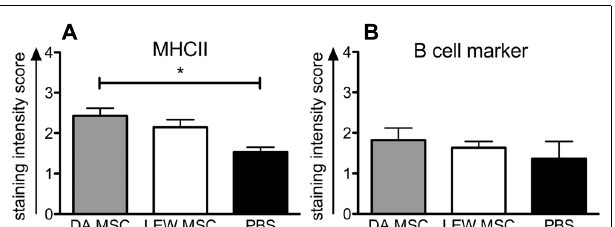
FIGURE 8 | Enhanced detection of MHCII-positive cells in rat spleens following MSC pre-treatment measured by immunohistology. Spleens were harvested at 8–10 days after kidney transplant and cryosections were labeled with specific monoclonal mouse anti-rat antibodies to B cell marker, MHCII, or with the isotype control antibody overnight at 4 ◦ C. A biotin-conjugated secondary antibody and streptavidin/horseradish peroxidase were applied before visualization with the substrate solution and counterstaining with Harris’s hematoxylin.Triplicate images were captured from each slide and the intensity of positive brown staining for (A) MHC II or (B) B cell marker was analyzed in a blinded approach on a scale of 0–3. Scores are given as mean ± SEM for triplicate slides with five to six rats in each group; * P <